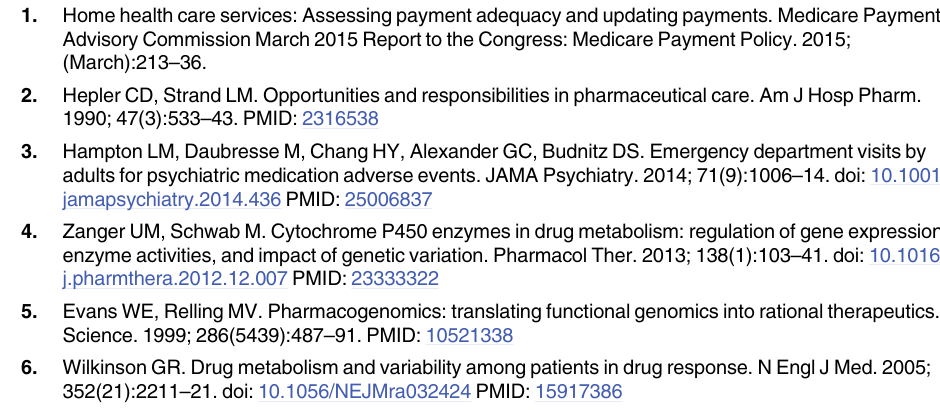
S4 Table. Comparison of differences in the demographic characteristics of patients between this trial and Hocum study. S5 Table. Estimated financial savings from re-hospitalizations and ED visits